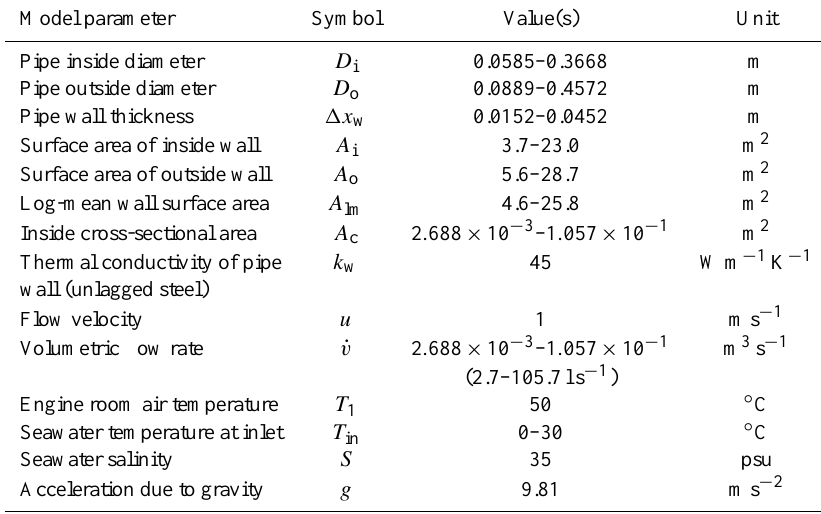
Table A3. Fixed parameters of our seawater intake warming model including their value(s) for Figs. A3 and A4. Model parameter